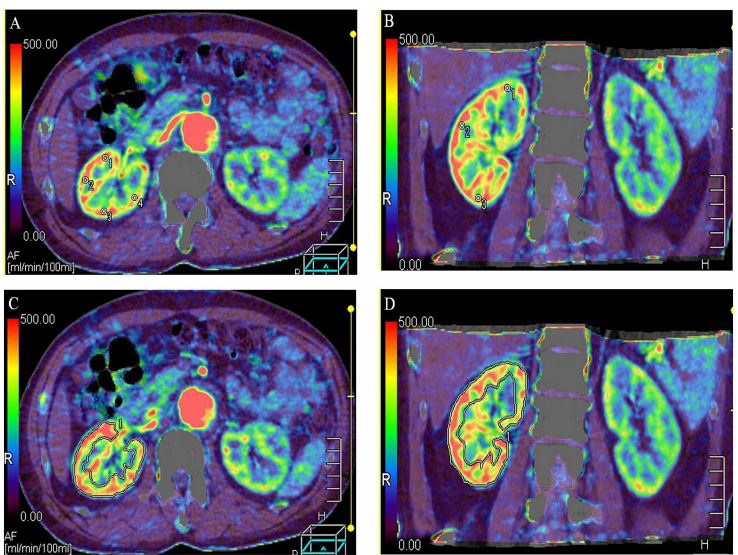
Fig 3. Examples of regions of interest (ROIs) measurements. (A) ROIs of renal cortex at axial view. (B) ROIs of renal cortex at coronal view. (C) ROIs of whole kidney were definedmanuallyon the axial plane. (D) ROIs of wholekidney on the coronal